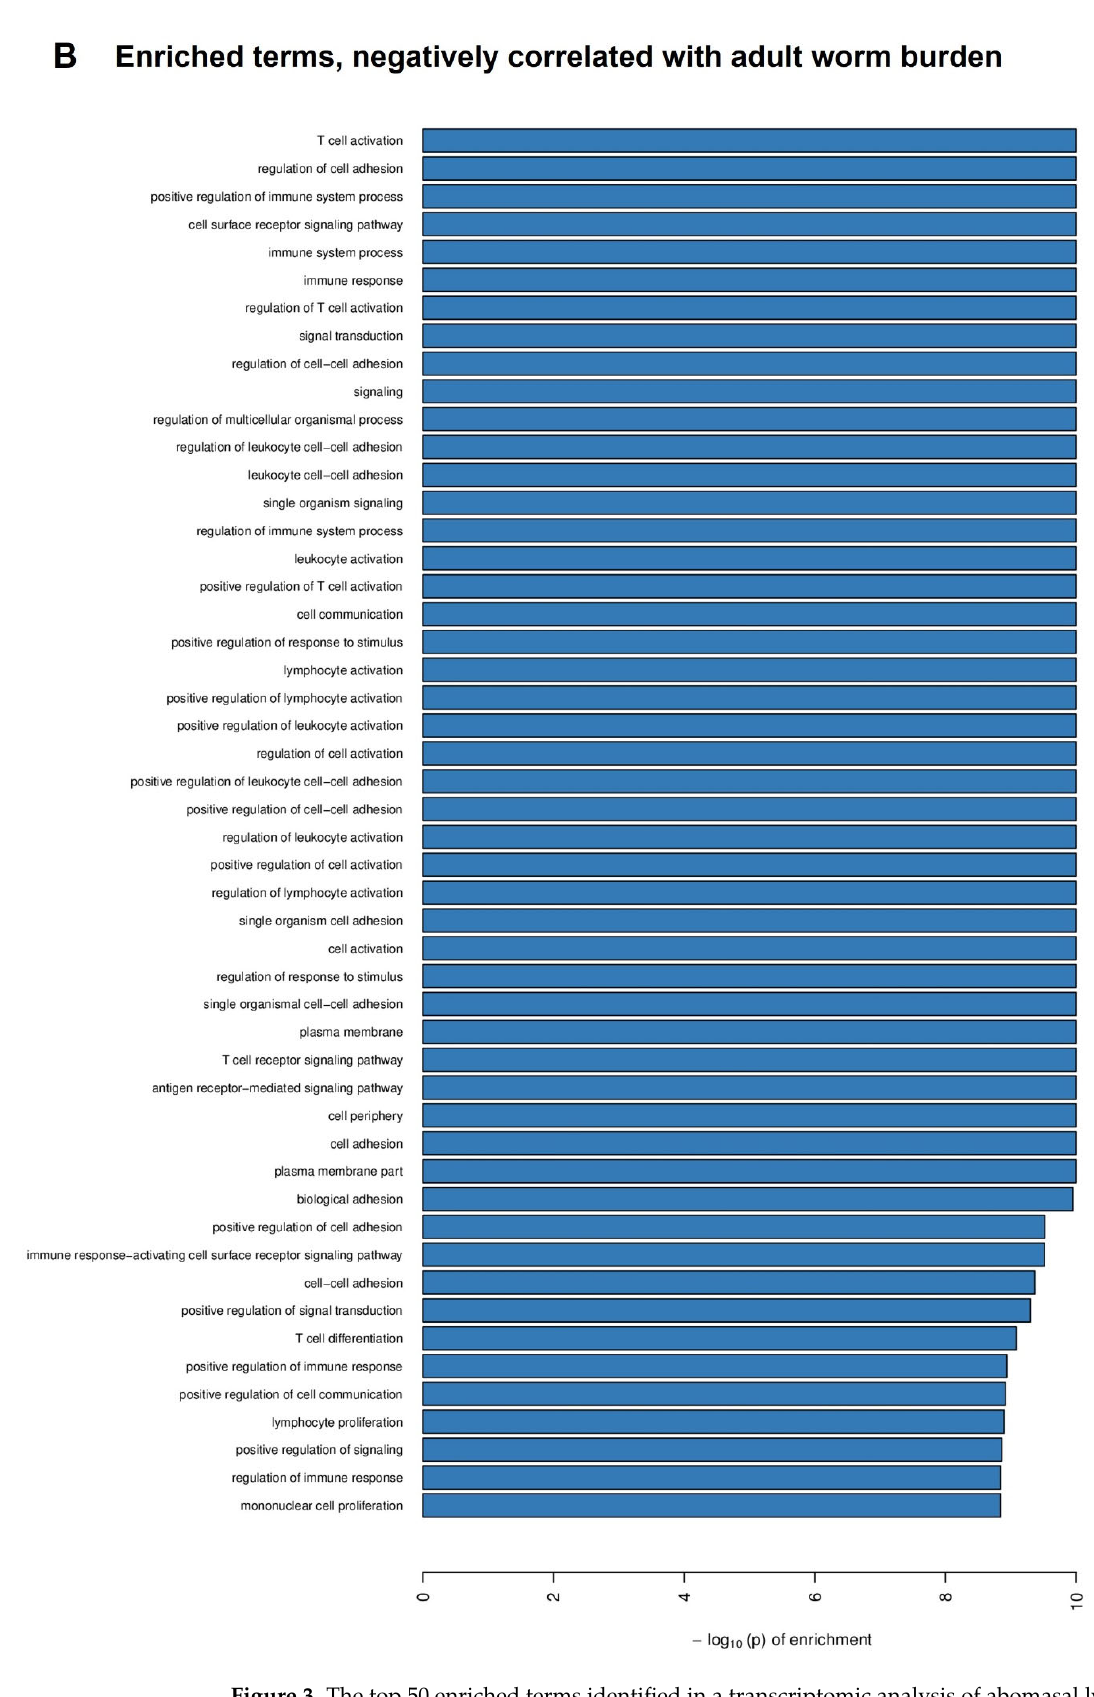
Figure 3. The top 50 enriched terms identified in a transcriptomic analysis of abomasal lymph nodes from three-month-old sheep after trickle infection with Teladorsagia circumcincta infective